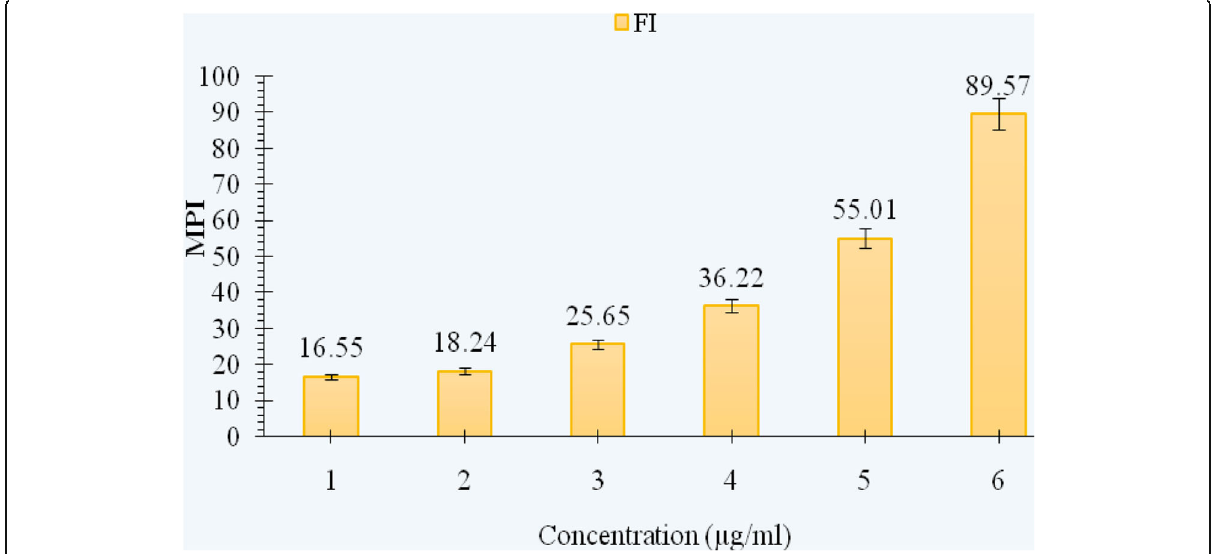
Fig. 4 Graph showing mean percentage inhibition of DPPH by ethanolic plant extract (F1)